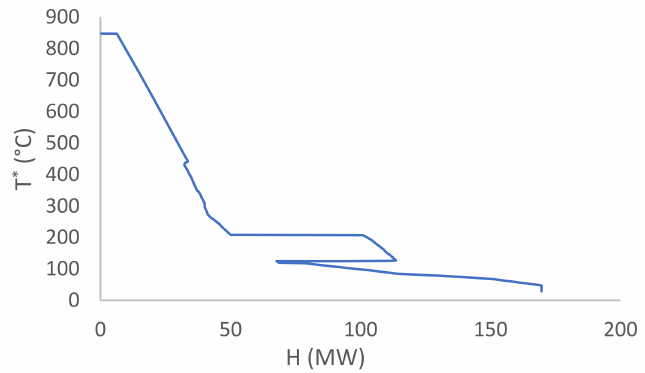
Figure 8. Grand Composite Curve.